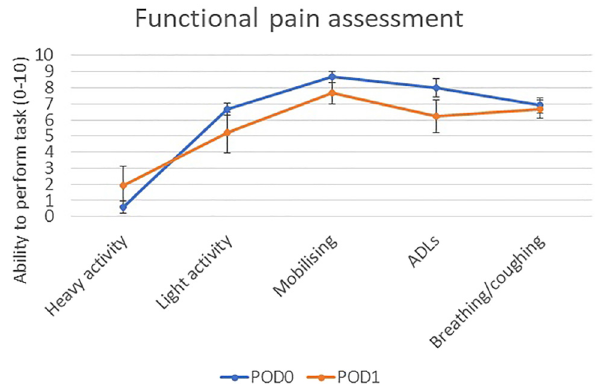
Figure 2: Pain scores over time following procedure assessed by telephone questionnaire (n=9).